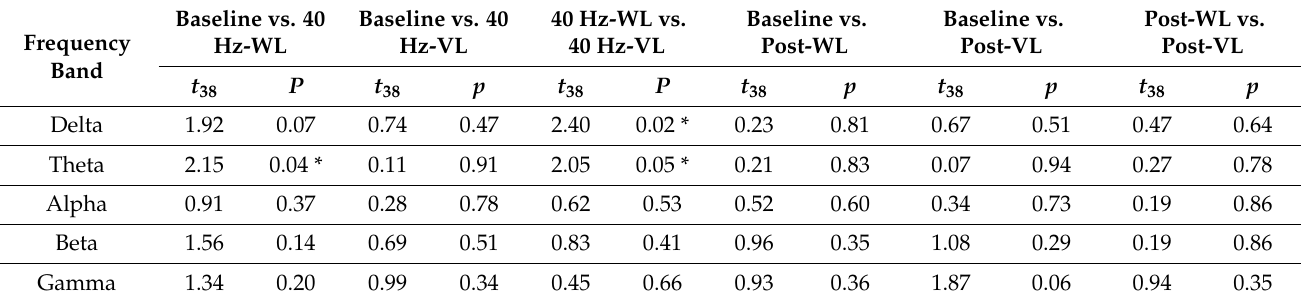
PSD of VEP with 40 Hz-WL vs. PSD of VEP with 40 Hz-VL At the electrode level, the analyses between the PSDs of VEP with 40 Hz-WL and 40 Hz-VL revealed that there was a difference in the PSD in gamma-band at the left parieto-occipital area, indicating that 40 Hz-VL showed a lower gamma modulation on PSD compared with 40 Hz-WL (Figure 4B, lower row). 3.2.3. Topographical Plots of PSD after the Light Stimulation Topographical plots of PSD after the light stimulation are shown in Figure 4C. PSD of Baseline EEG vs. PSD of Post-EEG with 40 Hz-WL Compared with PSD of baseline EEG, PSD for post-EEG with 40 Hz-WL stimulation showed partial EEG neuromodulations from the delta to beta bands at the electrode level. Specifically, PSD for post-EEG with 40 Hz-WL increased at the mid-prefrontal while it was reduced at the mid-parieto-occipital areas in delta band; PSD was reduced at the right parietal area in theta band; PSD increased at the left temporal area in alpha band; and PSD increased at the right temporal area in beta band (Figure 4C, upper row). PSD of Baseline EEG vs. PSD of Post-EEG with 40 Hz-VL Compared with baseline EEG, 40 Hz-VL stimulation induced enhanced PSD in beta band at the right parietal area and reduced PSD in gamma-band at the left parietal area (Figure 4C, middle row). PSD of Post-EEG with 40 Hz-WL vs. PSD of Post-EEG with 40 Hz-VL When compared the PSDs between VEP with 40 Hz-WL and VEP with 40 Hz-VL at the electrode level, 40 Hz-VL stimulation induced reduced PSD for post-EEG in delta band over the left and right prefrontal areas and increased PSD at the right parietal area; increased PSD in alpha band over the midline central area; and reduced PSD in gamma-band at the left parietal area, compared with 40 Hz-WL stimulation (Figure 4C, lower row). 3.2.4. Averaged PSD for the Prefrontal and Occipital Cortex during the Light Stimulation Averaged PSDs for the prefrontal and occipital cortex during the light stimulation are shown in Figure 5. In addition, statistical results are summarized in Table